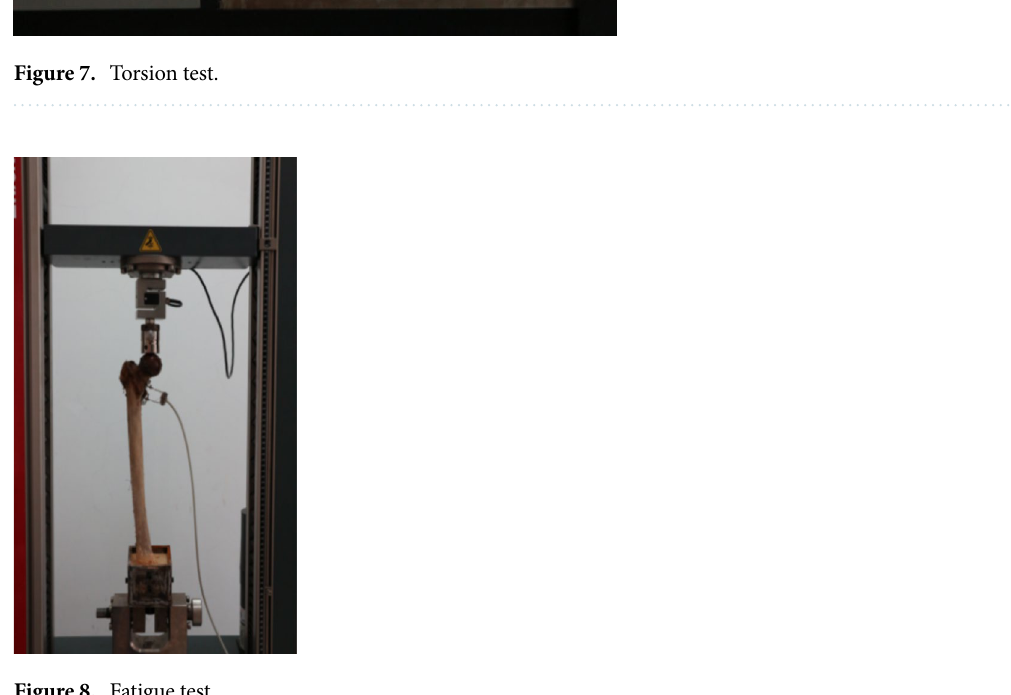
Figure 8. Fatigue